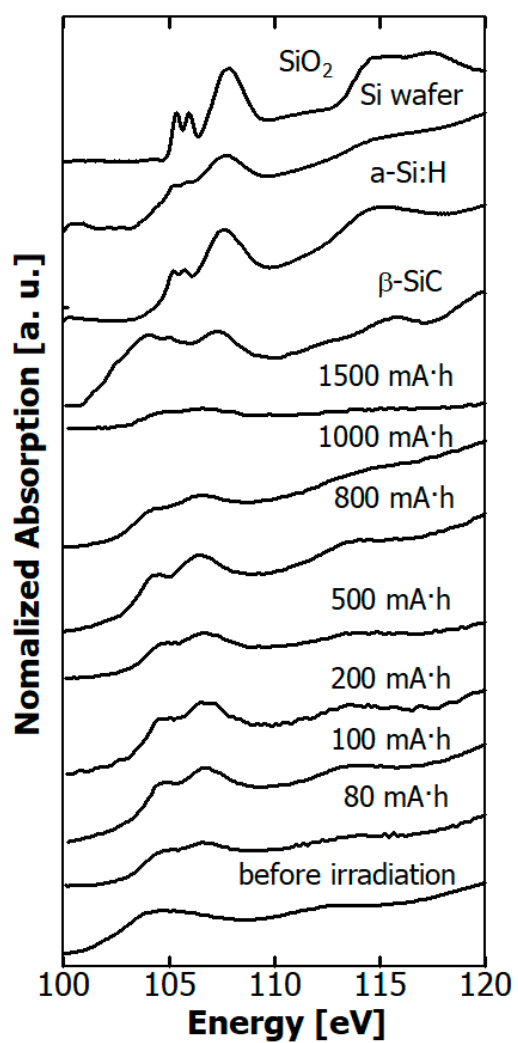
Figure 12. Dependence of Si L edge NEXAFS spectra of hydrogenated Si-DLC films on SR dose, together those of SiO 2 powder, Si wafer, a-Si:H film, and β -SiC powder.